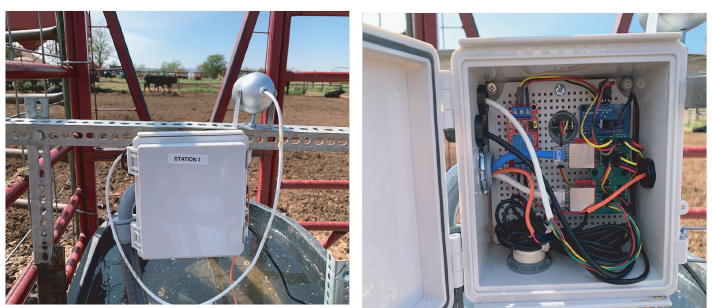
Figure 10. The junction electrical box implemented in each drinking